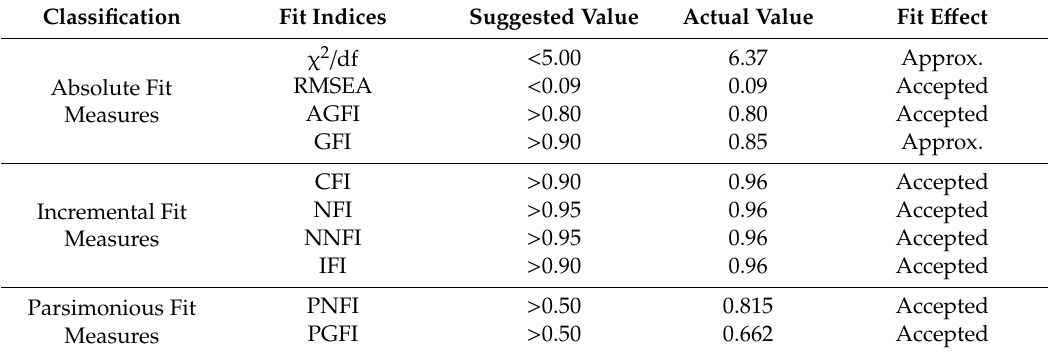
Table 5. Fitting indices of the Structural Equation Model.